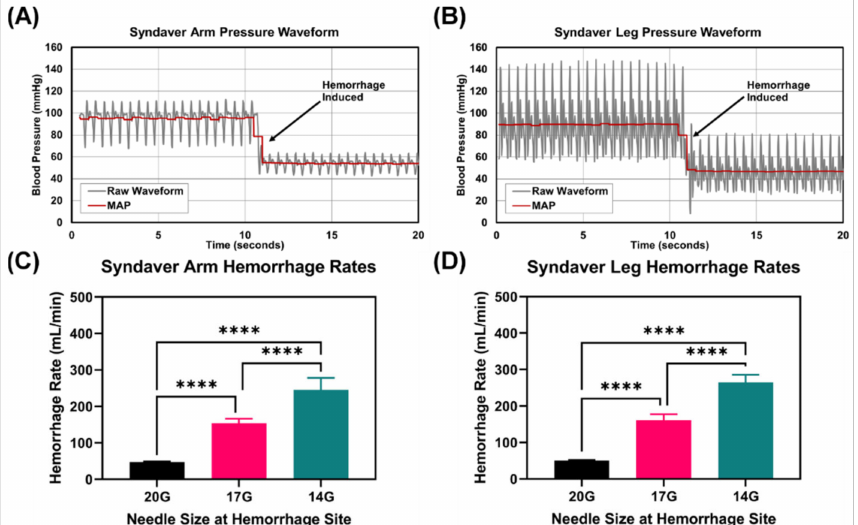
Figure 3. Physiological Features of the TKT test platform. Representative raw pressure waveform data and mean arterial pressure in the synthetic ( A ) arm and ( B ) leg. Hemorrhage induction is labeled and the effect on the pressure readings taken in-line with the hemorrhage site are shown. Average hemorrhage rates measured in the synthetic ( C ) arm and ( D ) leg. Three different bleed rates were recorded using a 20G, 17G, or 14G needle size to adjust the fluidic resistance at the hemorrhage site. Results reported as average values with error bars denoting standard deviation ( n = 24 for each). Significant differences between hemorrhage rates were determined by one-way ANOVA, post-hoc Tukey’s test (****, p < 0.0001).